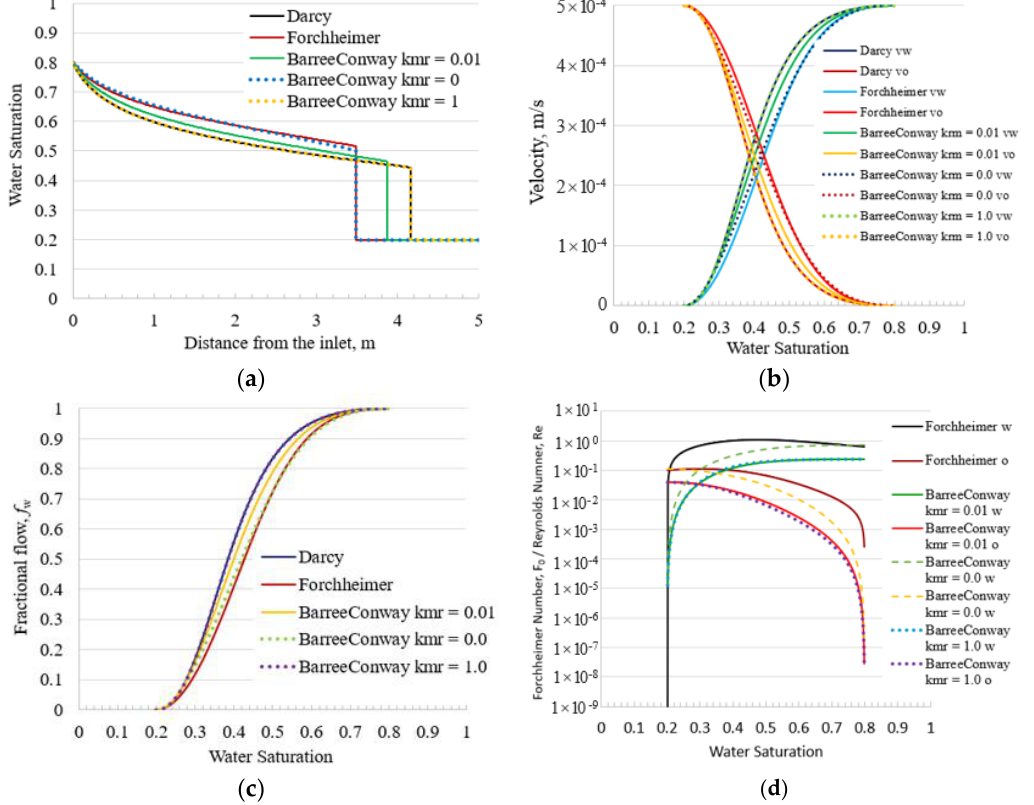
Figure 3. Comparison of Darcy, Forchheimer and Barree – Conway equations. ( a ) Water saturation profiles. ( b ) Velocity. ( c ) Water fractional flow curves. ( d ) Forchheimer number of Forchheimer equation and Reynolds number of Barree – Conway equation.